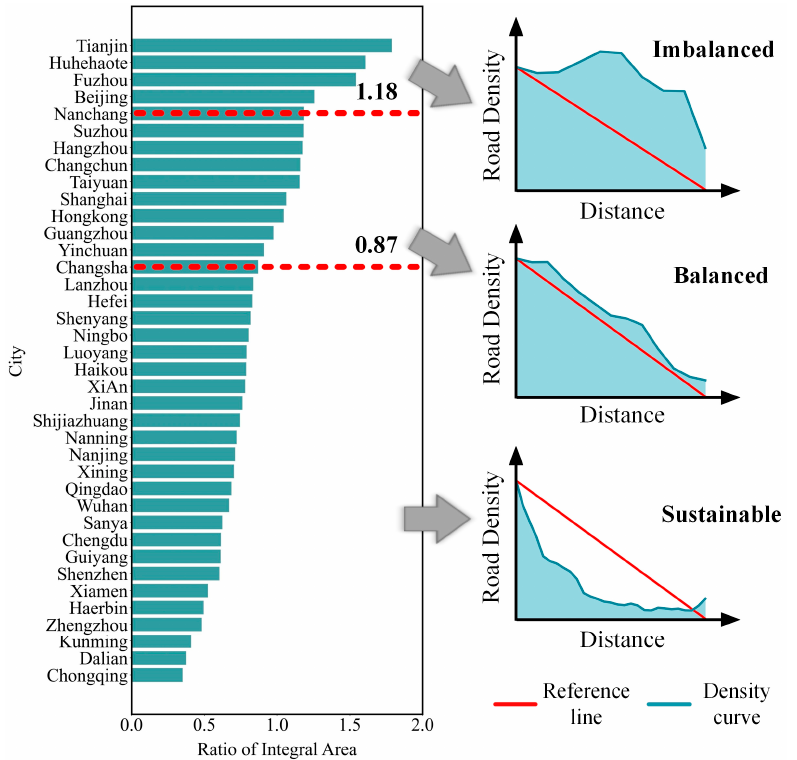
Figure 7. The integral area of different cities and the three types of road distribution patterns.